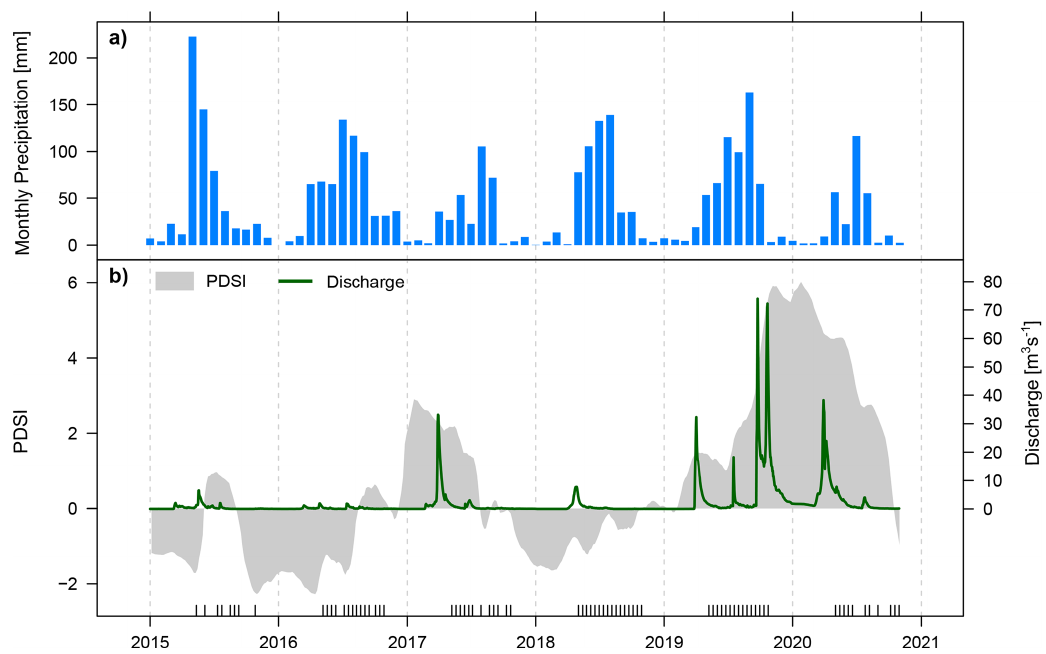
Figure 2. (a) Monthly precipitation sums at Jamestown Regional Airport (from Global Surface Summary of the Day, GSOD; © National Climatic Data Center, NESDIS, NOAA, U.S. Department of Commerce); (b) daily runoff at Pingree (© USGS) and the GRIDMET-derived PDSI (Abatzoglou, 2013) during the observation period. The rug plot at the bottom marks the dates of the Sentinel-1 acquisitions used in this